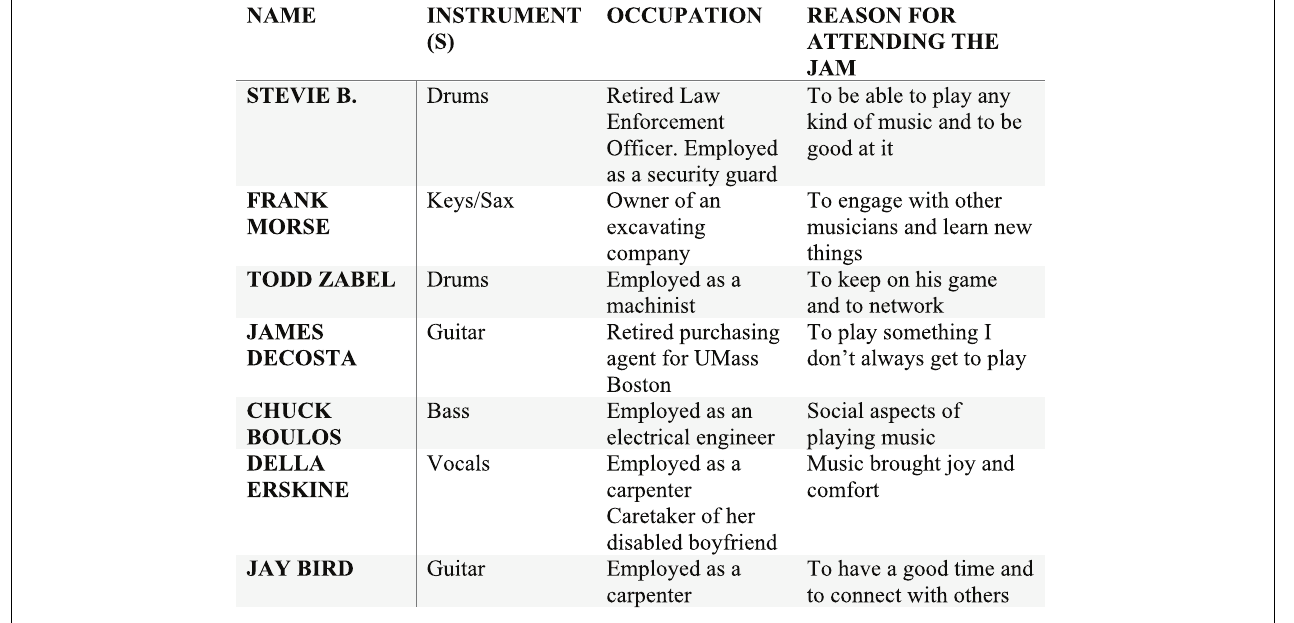
comfortable with the blues. Her friends said, “You know Della, you’d be a great blues singer,” so she learned blues standards and got gigs singing with local bands in the Boston